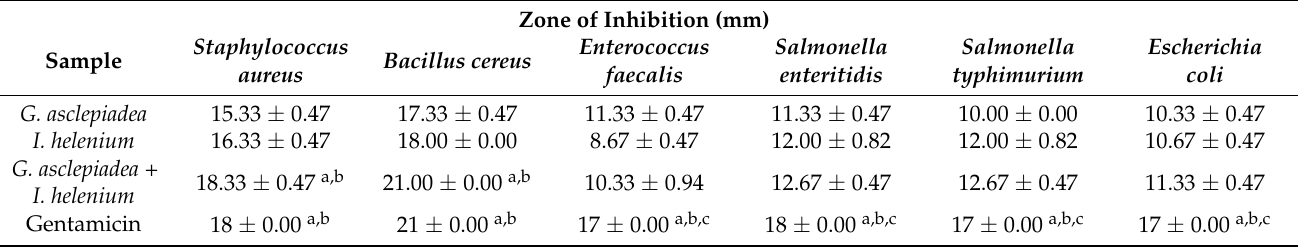
Table 4. Antibacterial activity of G. asclepiadea and I. helenium root ethanolic extracts (agar well- diffusion assay).